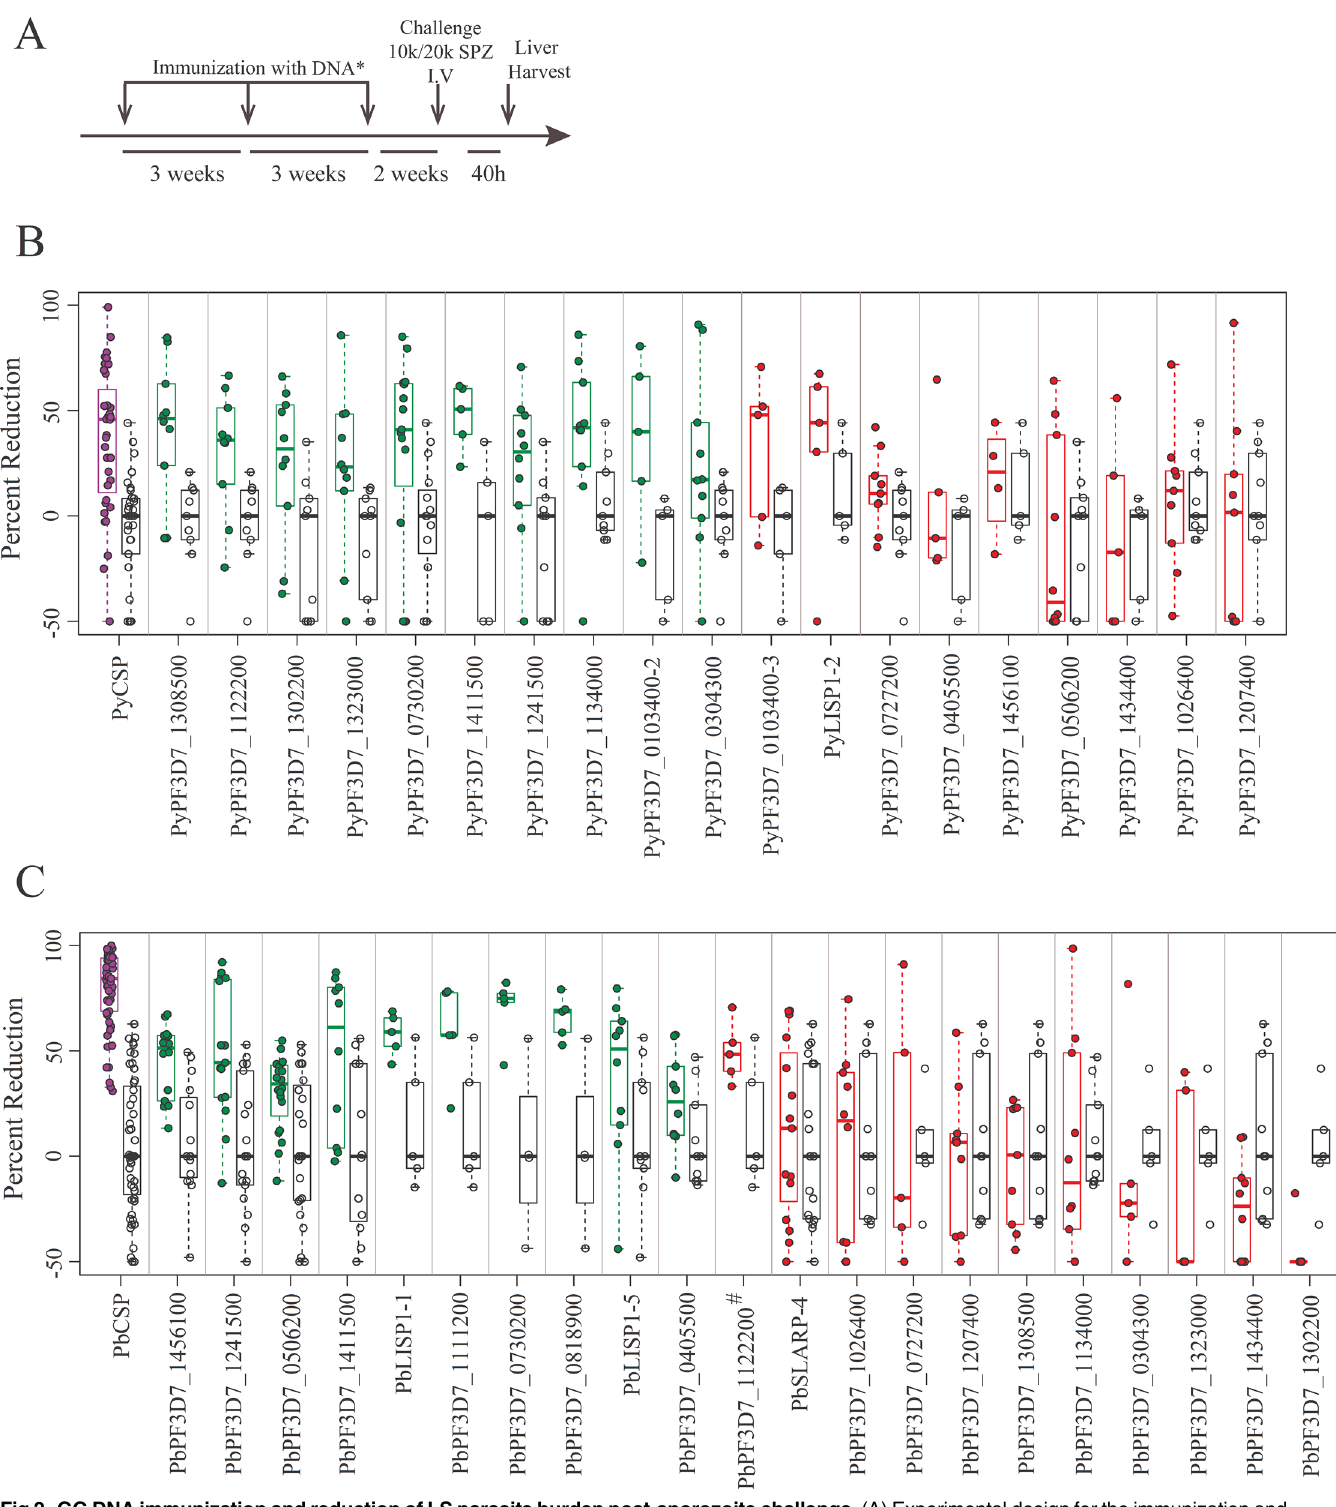
PLOS ONE | DOI:10.1371/journal.pone.0159449 July 19,